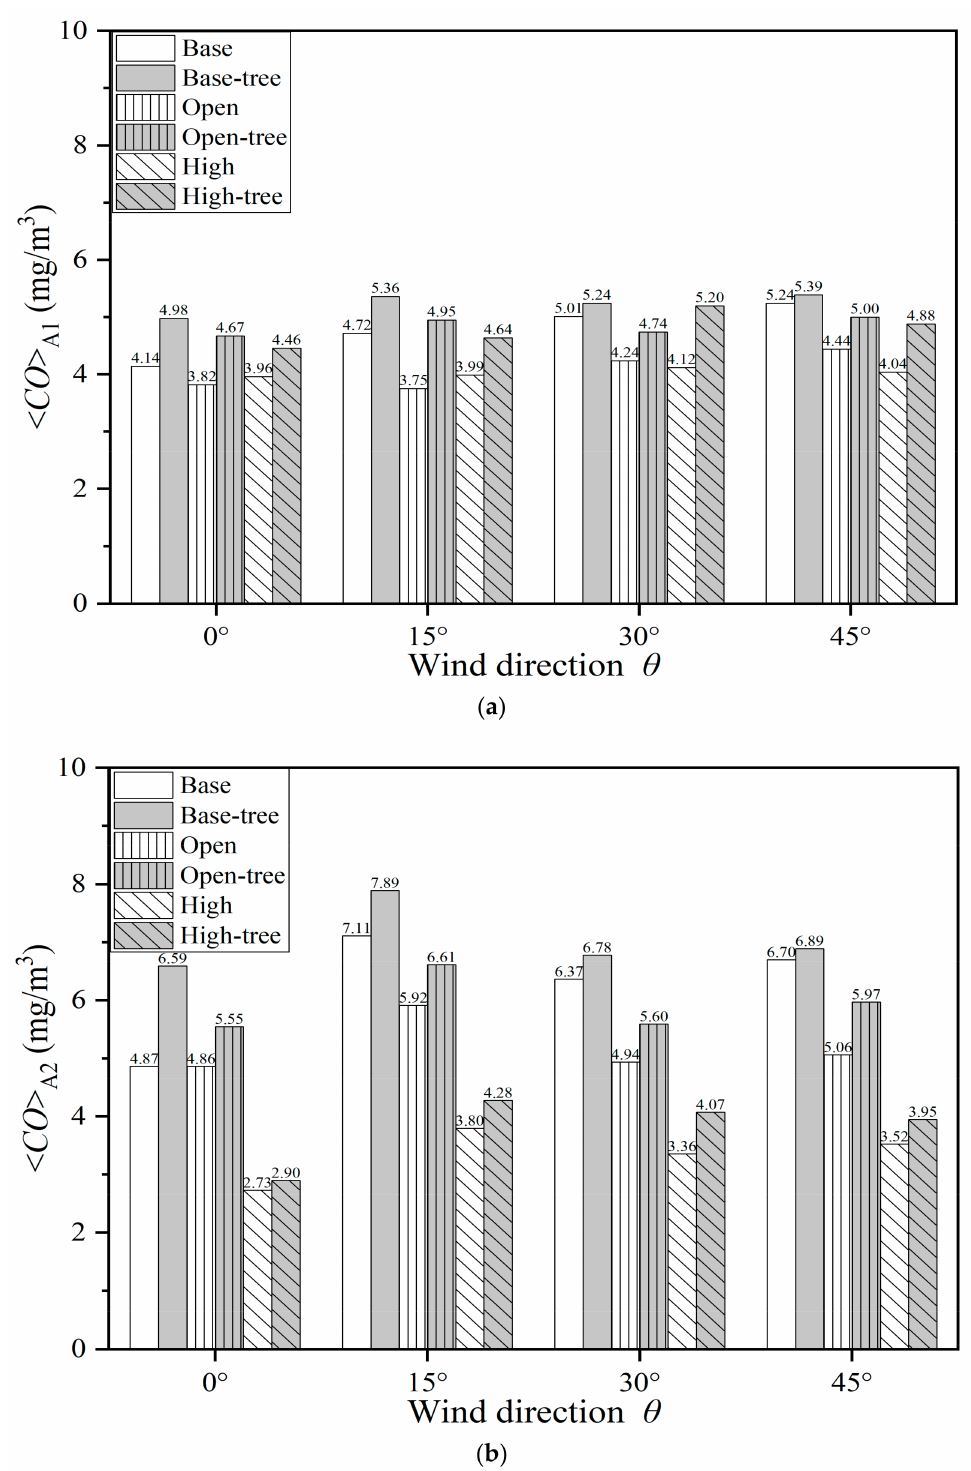
Figure 8. Spatially-averaged CO concentration in different scenarios at z = 2 m in ( a ) Region A1 and ( b ) Region